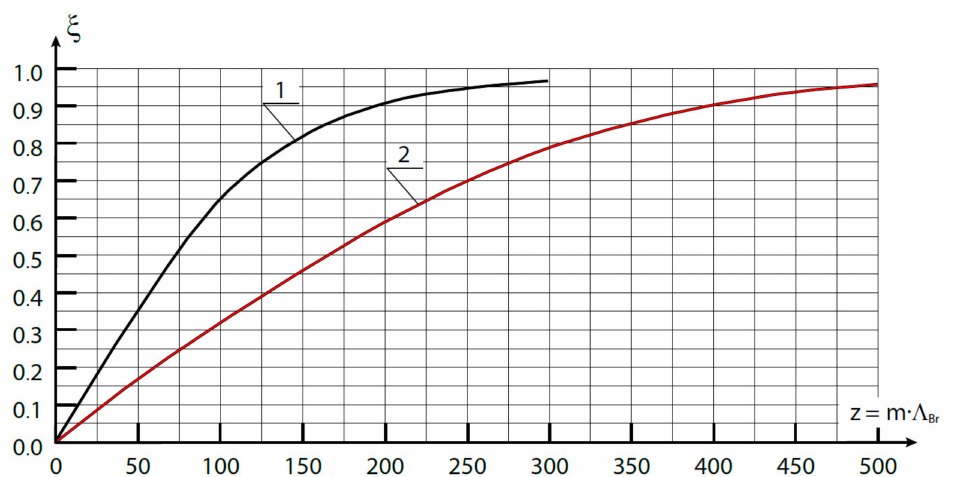
Figure 4. Illustration of the process of formation of the output mode by the V-FBG with different modulation of the refractive index: 1— ∆ n = 0.01 n 0 and 2— ∆ n = 0.001 n 0 , m is an integer—length of the grating in terms of number of ∧ Br ; ξ = | Φ LP 11 / Φ LP 01 |